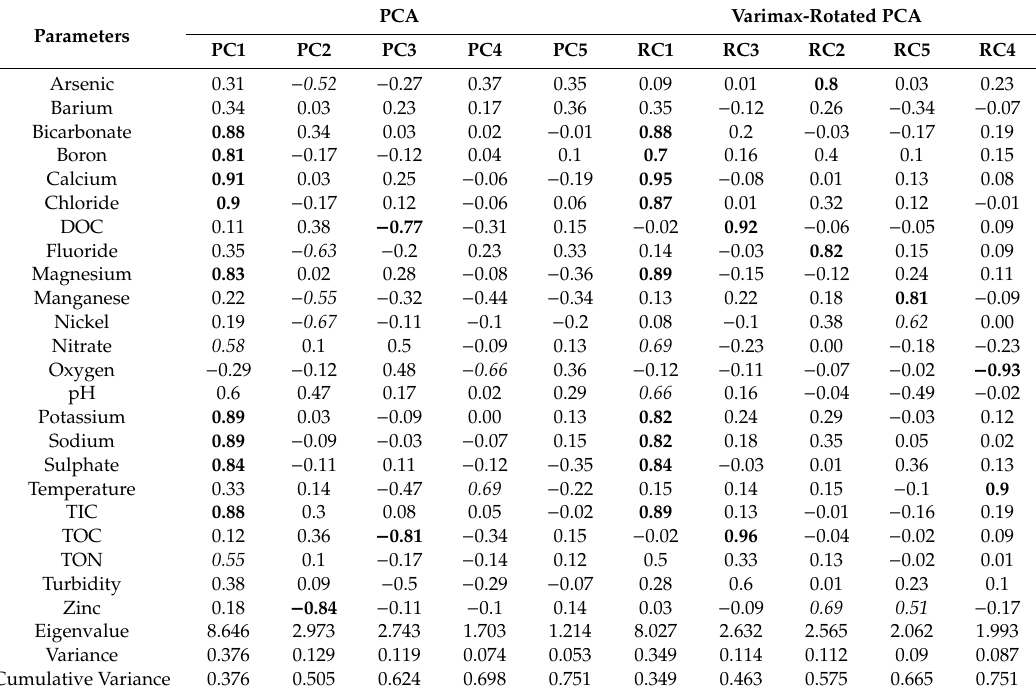
Loadings of the variables on the first five components according to PCA and varimax-rotated